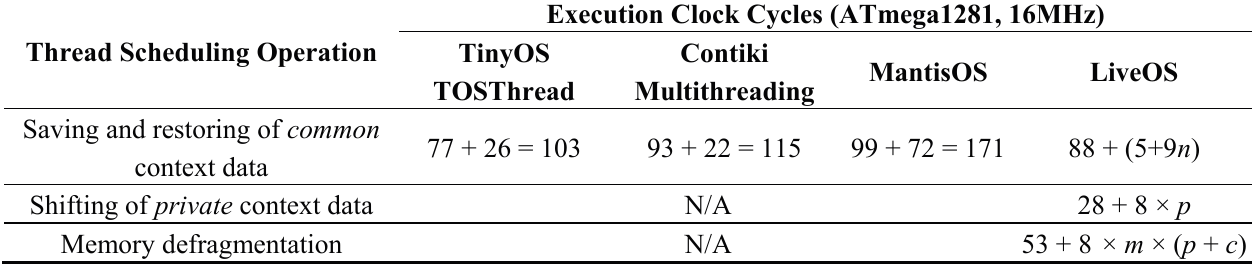
Table 2. Scheduling clock cycles of different multithreaded WSN